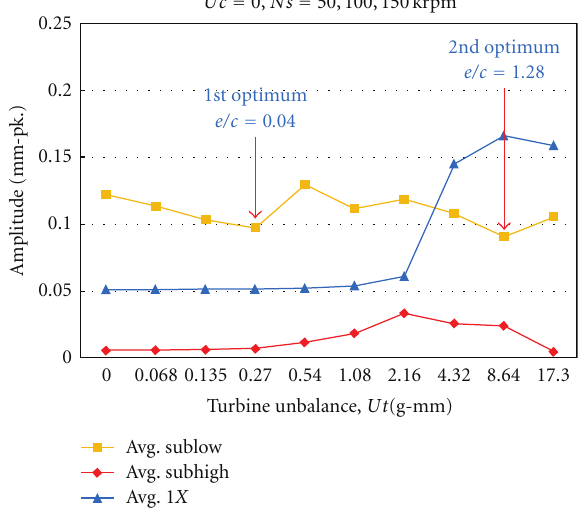
Figure 12: Predicted average compressor end (Station 1) vibration for induced turbine unbalance at speeds 50, 100, and 150 krpm.